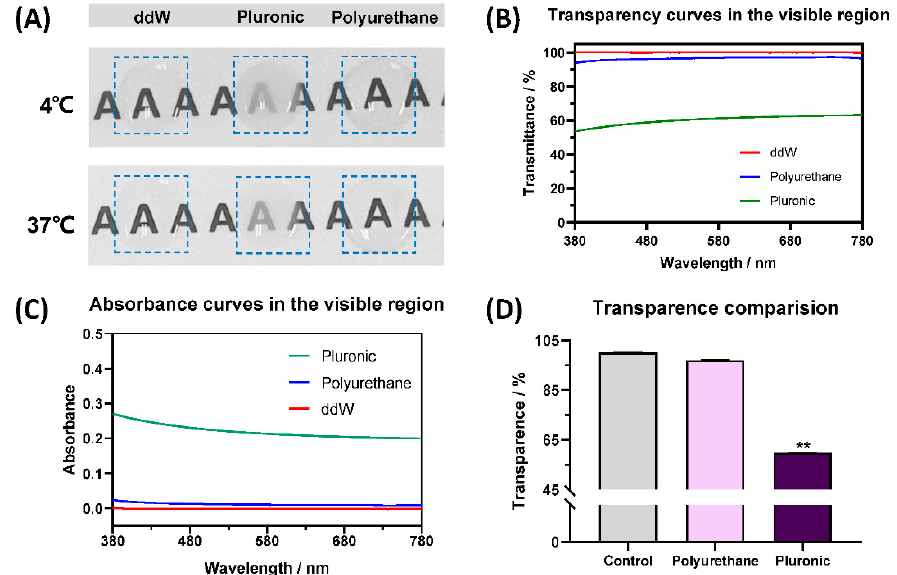
Figure 4. Optical properties of hydrogels: ( A ) macroscopic evaluation of transmittance performance; ( B , C ) transmittance and absorbance curves versus visible wavelength; ( D ) transmittance comparison (** p < 0.01).